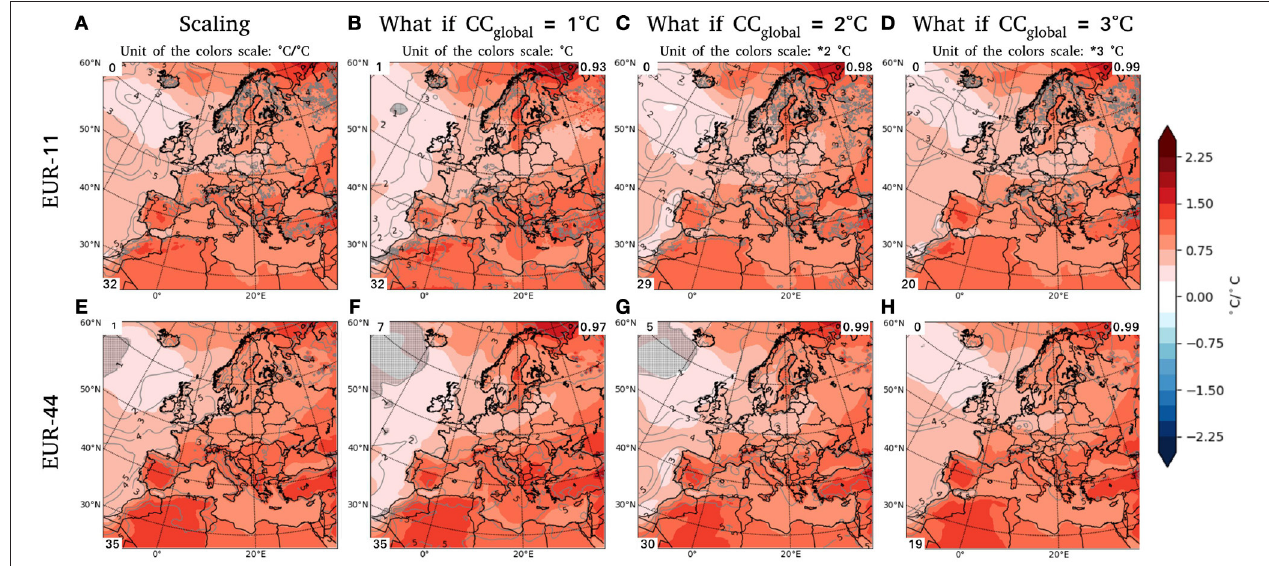
FIGURE 8 | JJA temperature. 2080–2099 scaled fields (A,E) , fields from the what-if approach for the 1 ◦ C (B,F) , 2 ◦ C (C,G) , and 3 ◦ C (D,H) for the EUR-11 domain and EUR-44 domain ( A–D and E–H , respectively). The metrics shown in the corners of the figures include the percentage of grid points where S/N < 1 (upper left), the number of model members (lower left) and the correlation between the scaled pattern and the what-if approach (upper right for the what-if subplots). It is worth noting that the scale of the what-if patterns have to be multiplied by their threshold values to obtain actual